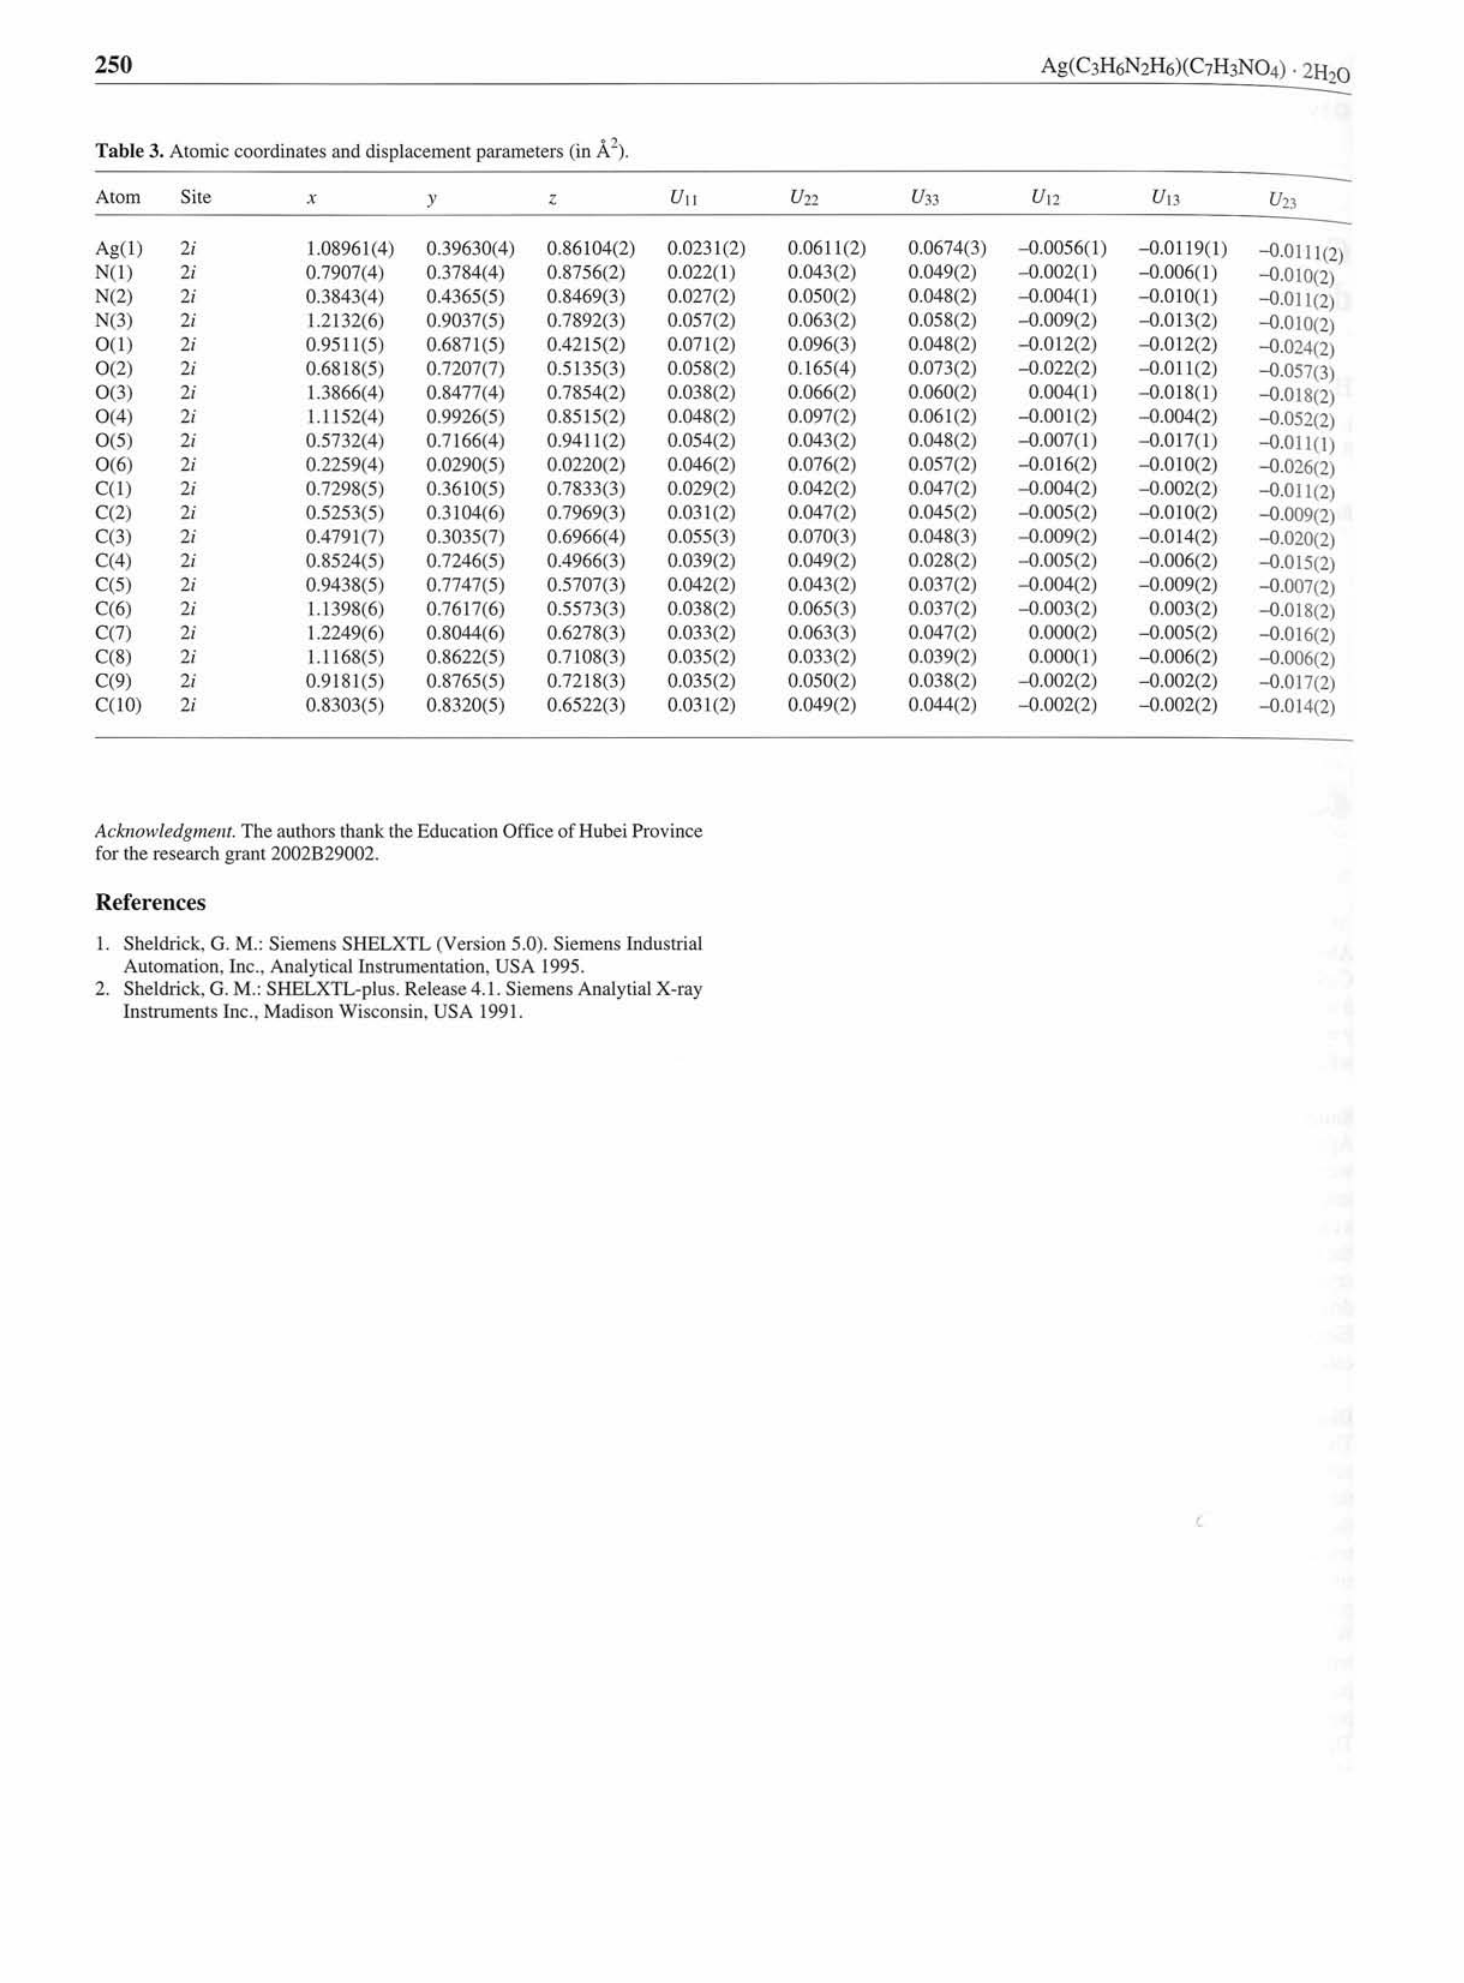
Table 3. Atomic coordinates and displacement parameters (in Â 2